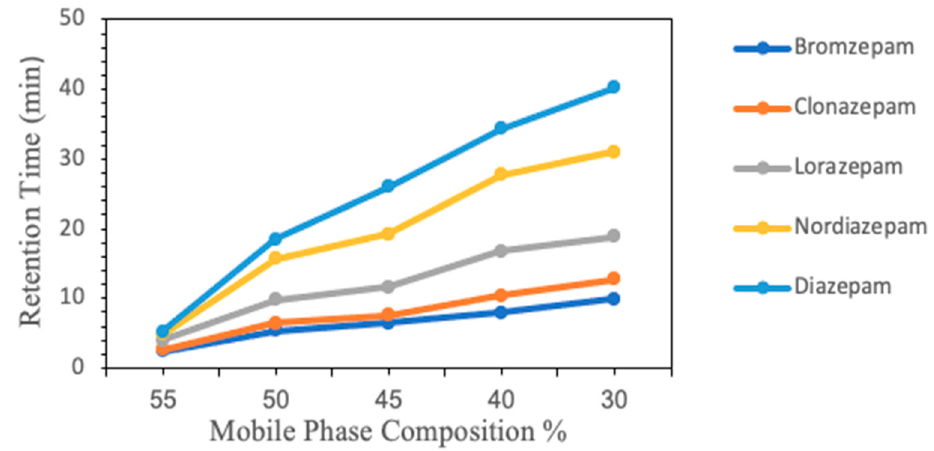
Figure 2. Effect of methanol composition in the mobile phase on the retention times of selected BZDs. Other experimental conditions as described in the text.